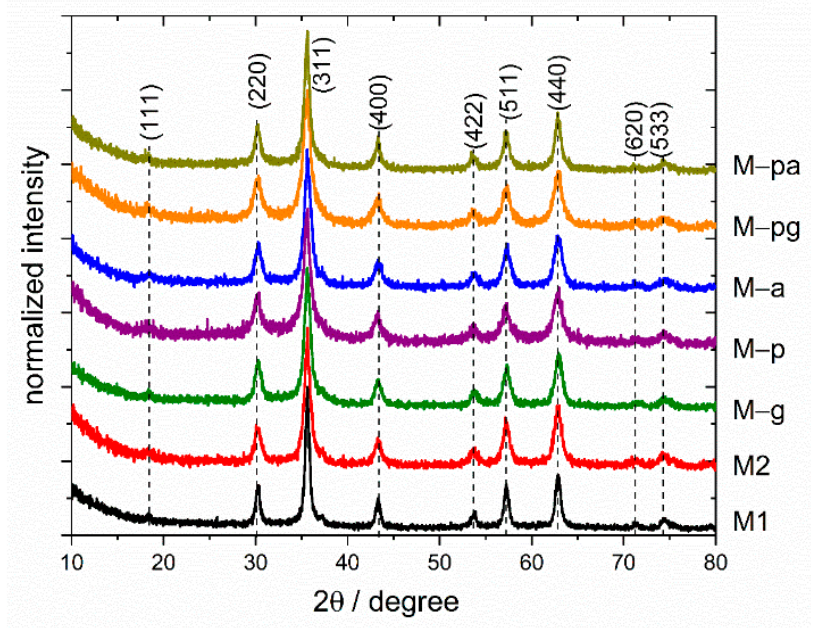
Figure 1. XRD patterns of iron oxide nanoparticles synthesized using a co-precipitation method. The diffractograms were normalized by the maximum of (311) diffraction in all cases, and the base line was displaced between every curve for better view.